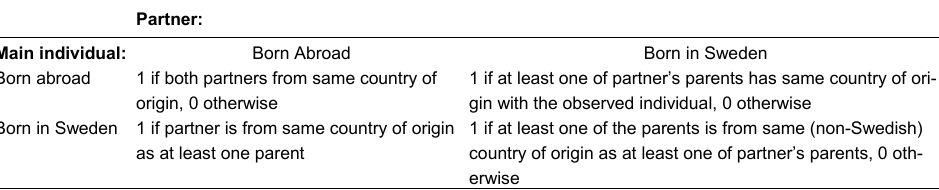
Table 1: Definition of ethnic endogamy: Assortative mating by country of